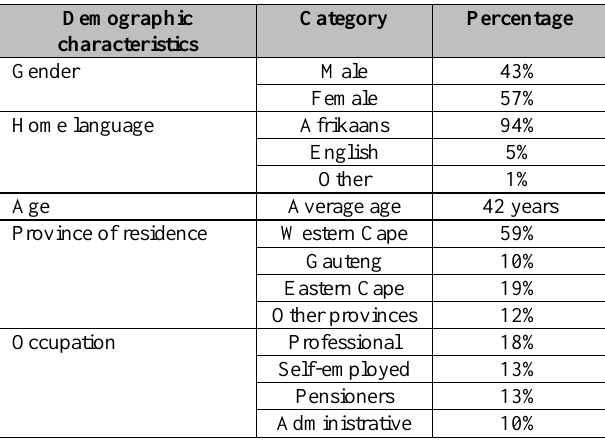
Table 2: Demographic profile of respondents Demographic